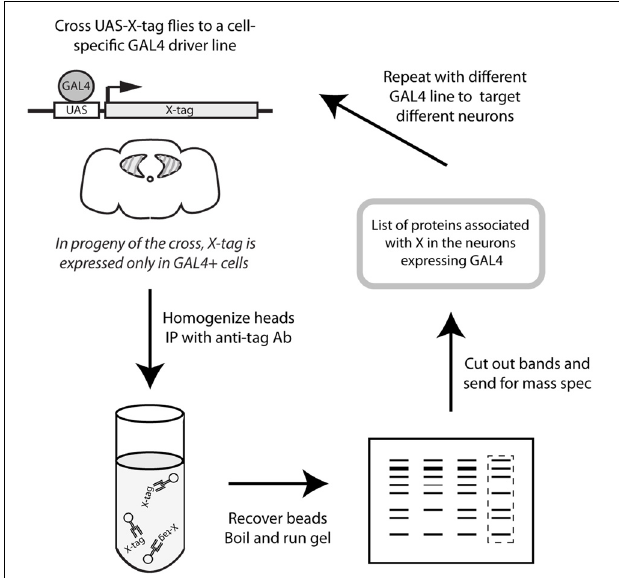
FIGURE 1 | Schematic representation of protocol. CASK-YFP fusion proteins were expressed in a cell-specific manner using the GAL4/UAS system (Brand and Perrimon, 1993) on a CASK- β null background (Slawson et al., 2011) to ensure that the only CASK- β present was the product of the transgene. Adult heads were collected and homogenized, and CASK proteins were recovered with anti-GFP-conjugated beads. Eluted proteins were separated by SDS-PAGE and Coomassie-stained gels were sent for analysis by mass spectrometry to determine the proteins which associate with CASK in the cell type targeted by the specific GAL4 line.